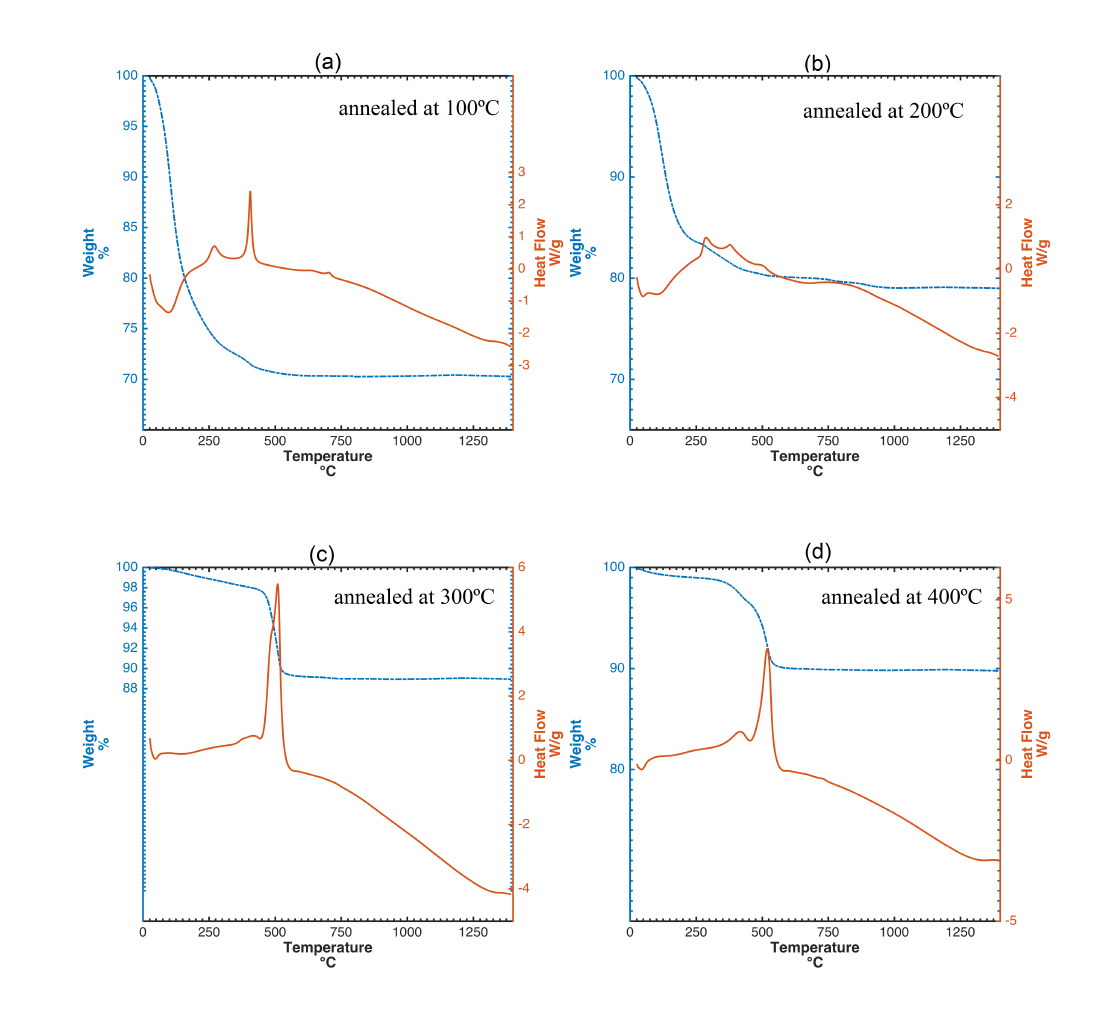
Figure 4. TGA and DSC curves of nano-TiO sols calcined at different temperatures: ( a ) annealed at 2 100 ◦ C, ( b ) 200 ◦ C, ( c ) 300 ◦ C, ( d ) 400 ◦ C. ( a – c ) Anatase phase transformation into rutile is affected by the annealing temperature and ( d ) by the initial particle